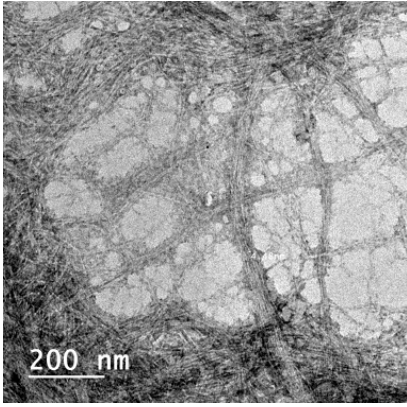
Figure 1. TEM image of cellulose nanofibers isolated from xylanase-treated rice straw unbleached neutral sulfite pulp.